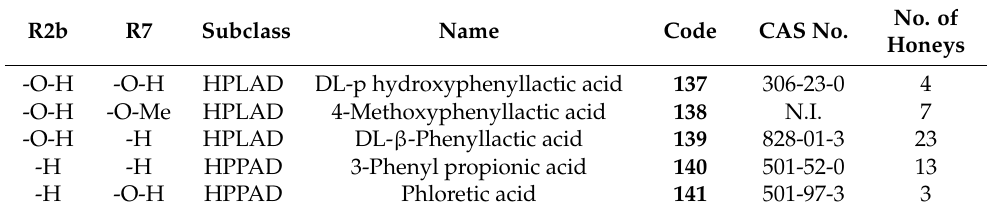
Figure 18. Basic structure of hydroxyphenyllactic acid and derivatives (HPLAD) (see 137 – 139 in Table 12) and hydroxyphenylpropanoic acid and derivatives (HPPAD) (see 140 and 141 in Table 12). Table 12. Hydroxyphenyllactic acid and derivatives (HPLAD) and hydroxyphenylpropanoic acid and derivatives (HPPAD) reported in monofloral honeys (see Figure 18 for general structure).